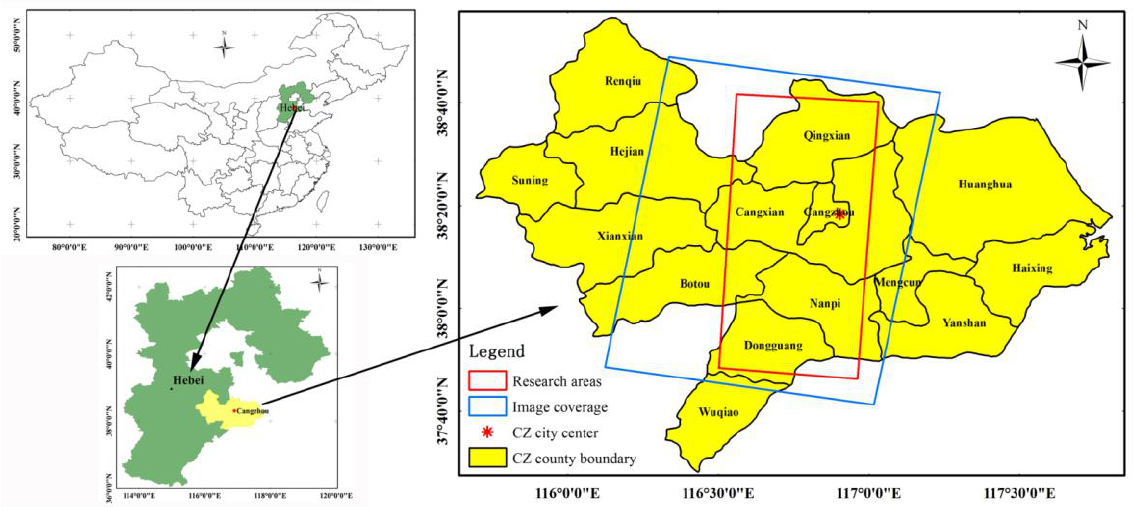
Figure 1. The location map of Cangzhou City,is backed by Beijing and Tianjin, south of Shandong, east of the Bohai Sea, west of Hengshui, which is including 14 counties and three districts (Xinhua, Yunhe and Development Zone). the total area of Cangzhou is nearly 14500km 2 ,and also is one of the rapid economic development of the Hebei Province